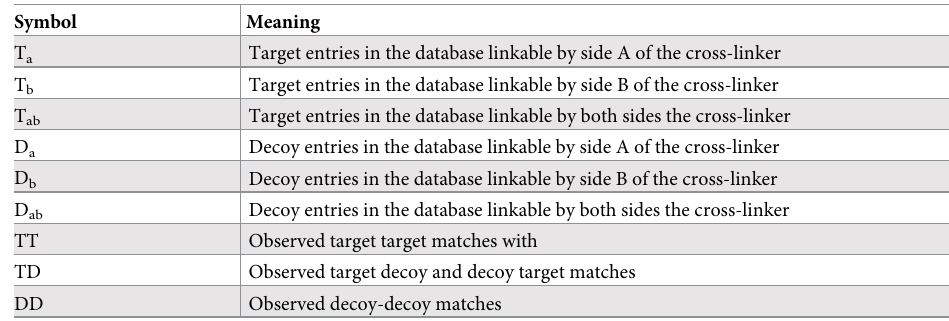
Table 1. Formula